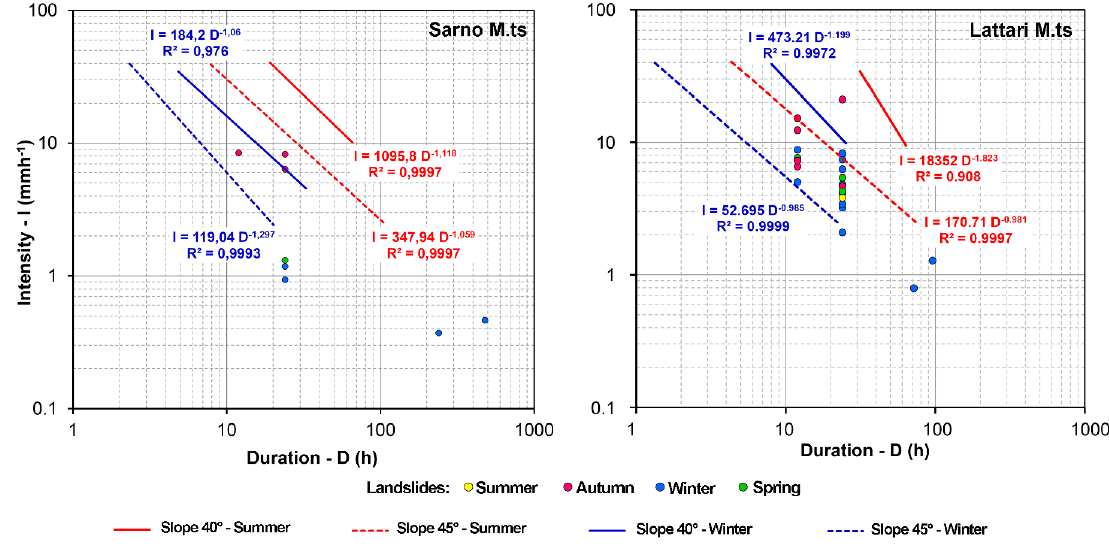
Figure 9. Intensity−duration rainfall thresholds reconstructed for 35°, 40°, and 45° slope models of the Sarno ( a ) and Lattari Moutains ( b ) and winter and summer antecedent hydrological conditions. Colored circles represent I-D rainfall conditions recorded for debris flow events known by chronicles and scientific literature, seasonally divided [50–52].